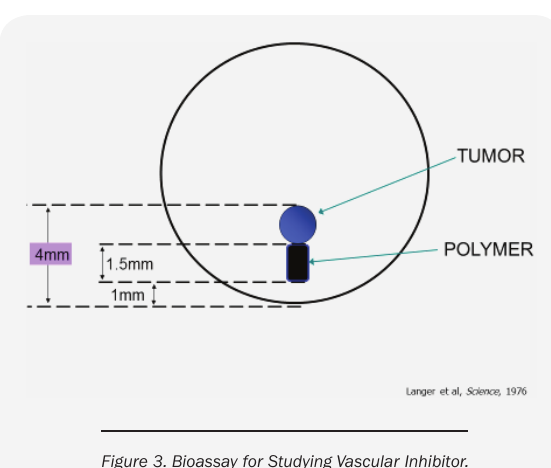
Figure 3. Bioassay for Studying Vascular Inhibitor.